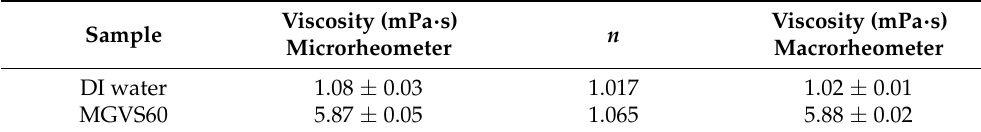
Table 3. Viscosity obtained using the developed microrheometer (with the corresponding n values obtained) and a commercial macrorheometer and electronic detection methods. The samples analyzed were DI water and MGVS60, a commercial standard